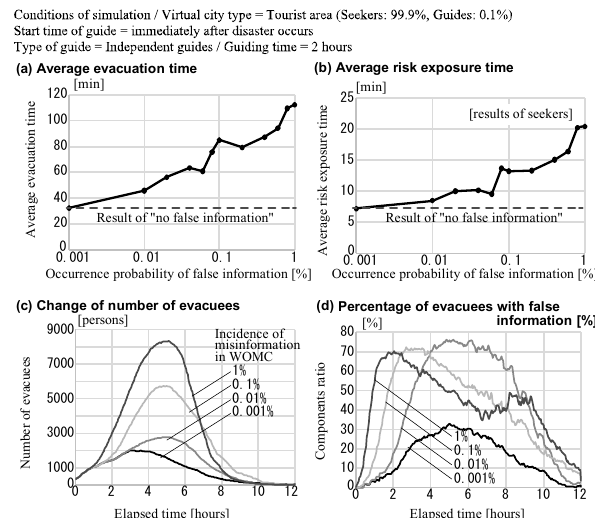
Figure 16. Influence of misinformation spreading